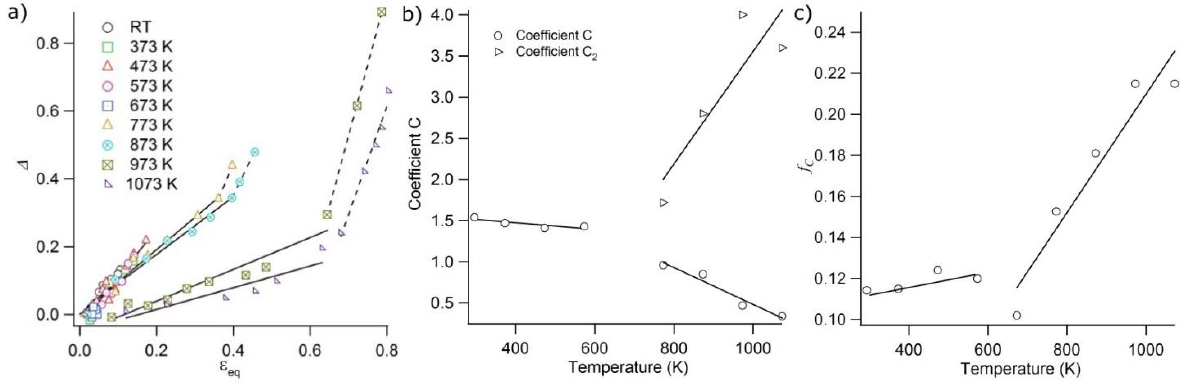
Figure 7. ( a ) Evolution of the parameter Δ of Equation (7) as a function of the equivalent strain for temperatures between RT and 1073 K. ( b ) Effect of temperature on C and C 2 coefficients. ( c ) Evolution of the critical void fraction as a function of the